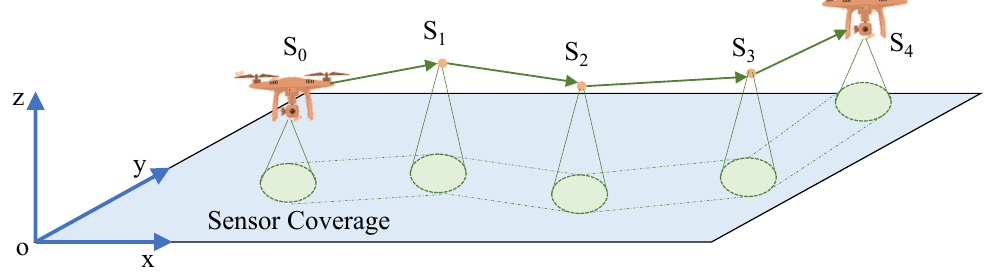
Figure 2. Path Planning for